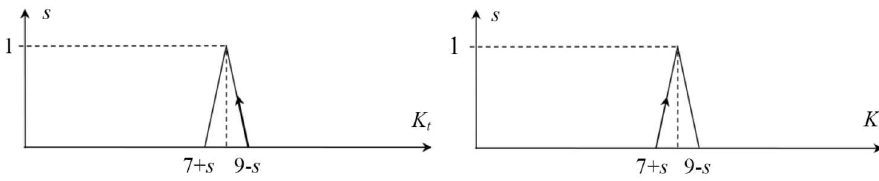
Figure 6. OFN of fuzzy transportation